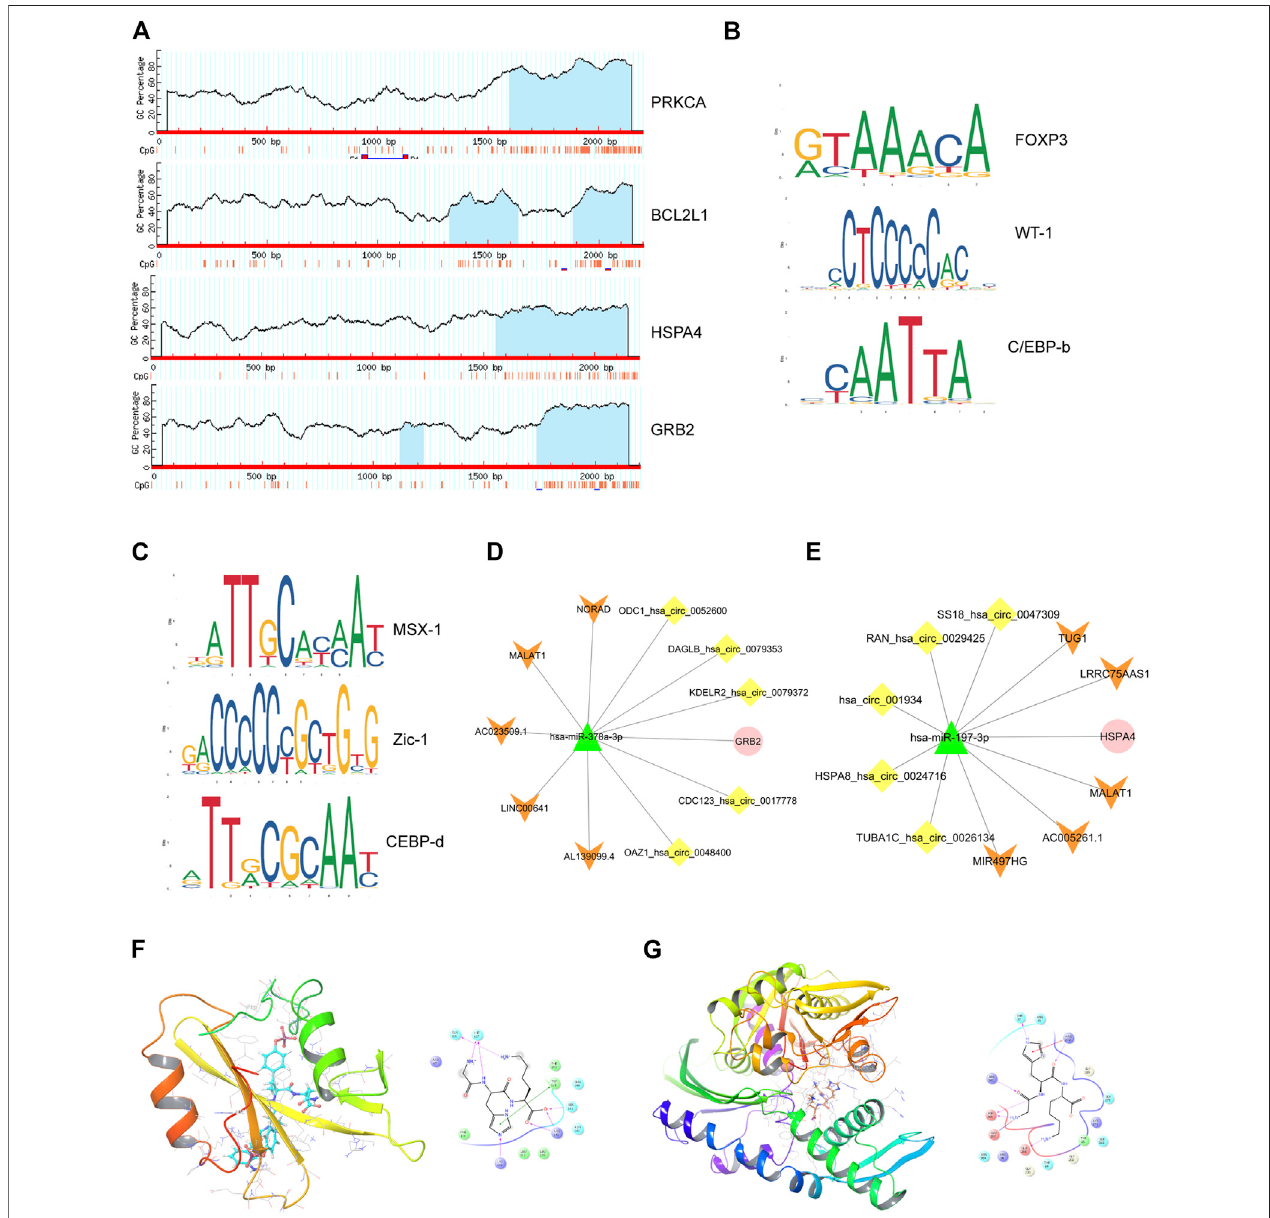
FIGURE 6 | Comprehensive epigenetic regulation prediction of the four hub genes. (A) , CpG islands prediction analysis of 4 hub genes. (B) , Representative predicted transcription factors of target GRB2 islands enriched in DMRs. (C) , Representative predicted transcription factors of target HSPA4 islands enriched in DMRs. (DandE) ,CeRNAregulatorynetworkofGRB2andHSPA4. (F) ,simulationofmoleculardockingpatternbetweenGRB2(PDBID:6ICG)andGly-His-Lys. (G) ,simulation of molecular docking pattern between HSPA4(PDB ID: 3QFP) and Gly-His-Lys.